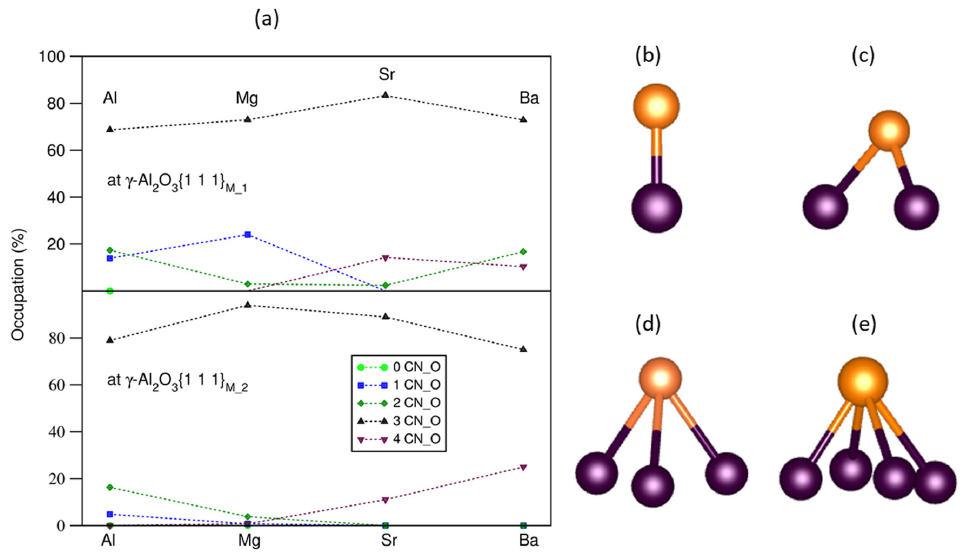
Figure 4. The statistics of the occupation rates of the segregated AE at the O sites (O coordination numbers) ( a ), the schematic structures of AE-O ( b ), AE-2O ( c ), AE-3O ( d ), and AE-4O ( e ) bonding at the L-Al/ γ -Al 2 O 3 interfaces. In ( b – e ), the dark brown spheres represent O, and the gold spheres represent AE